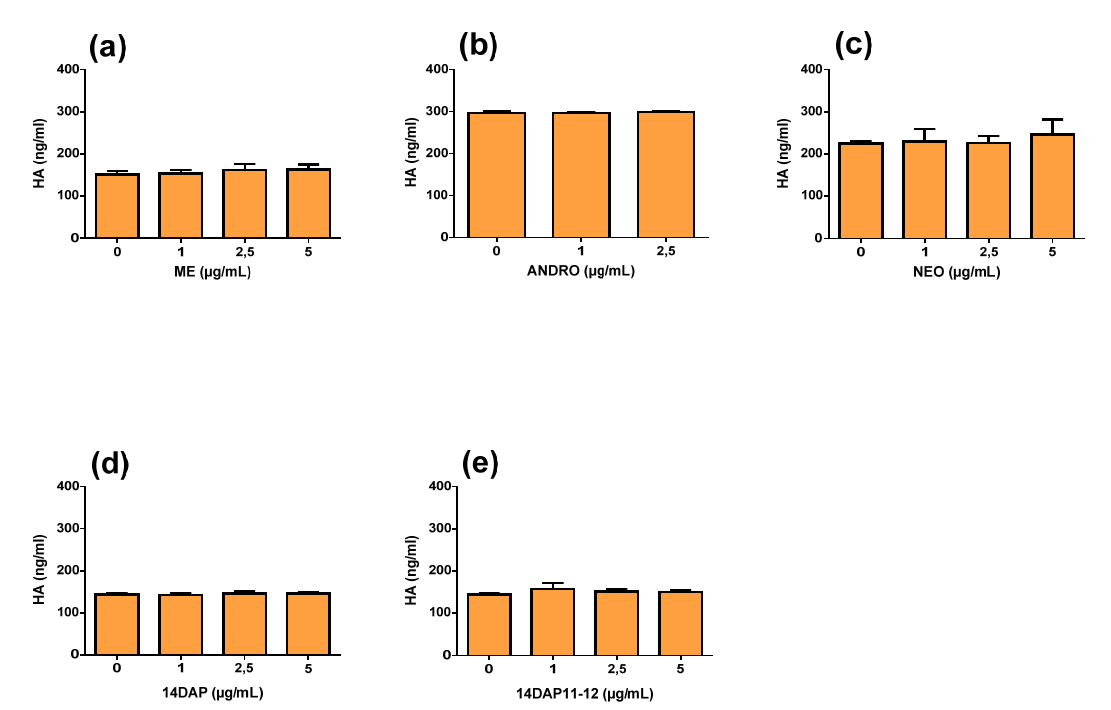
Figure 6. HA production and e ff ect of ME, ANDRO, NEO, 14DAP, and 14DAP11-12 in HaCaT. ME ( a ), ANDRO ( b ), NEO ( c ) 14DAP ( d ), or 14DAP11-12 ( e ) was used at 1, 2.5 or 5 µ g / mL for 48h. HA was determined by an ELISA. The values are mean ± SD, * p < 0.05, ** p < 0.01 compared with control group, n= 3. Abbreviations: HA, hyaluronic acid.